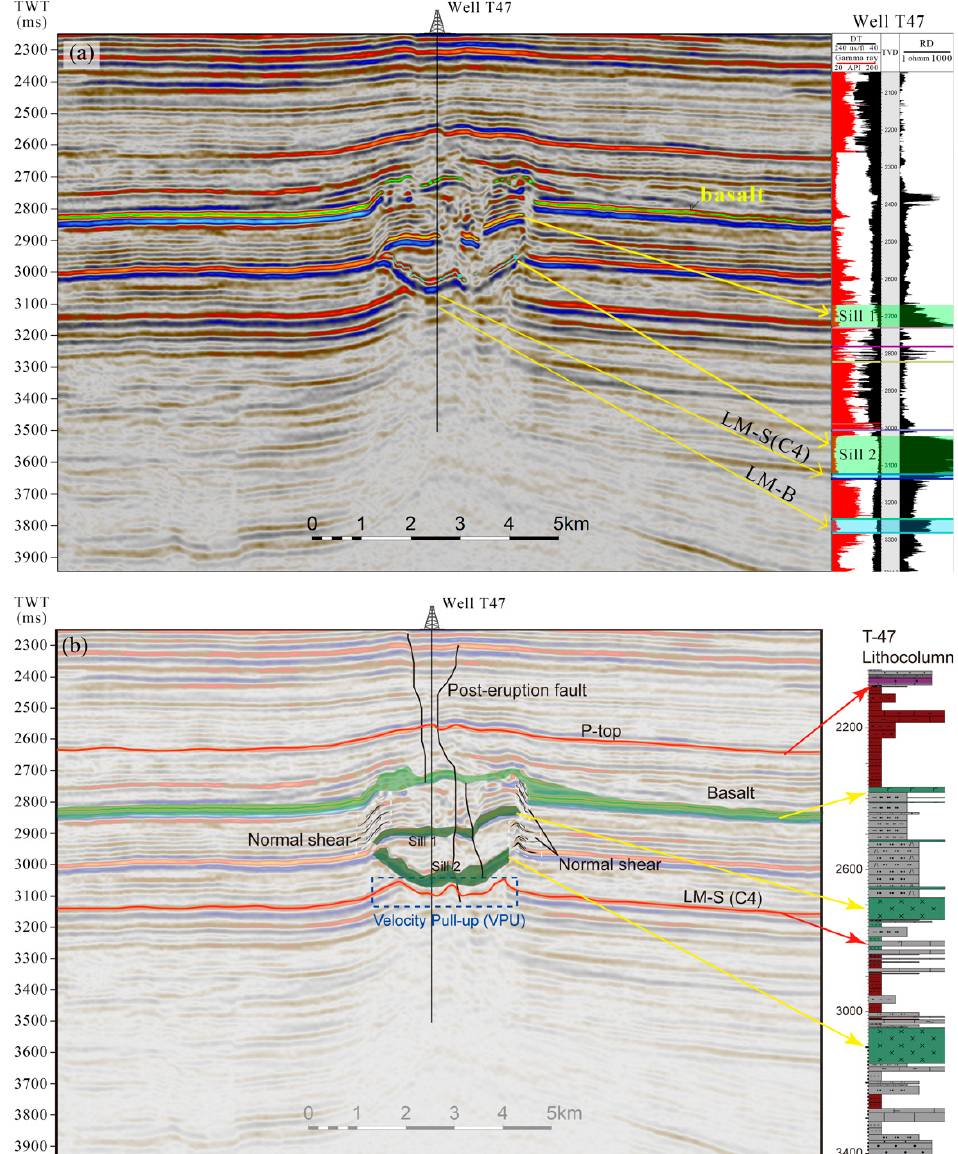
Figure 3. ( a ) Seismic profile across well TZ-47, illustrating the geometry, scale, and seismic expression of two basaltic sills in TZ-47 area, and their correlations with down-well logging data; ( b ) interpretation sketch of the seismic profile and its correlation with the lithocolumn of T-47. Acronyms used in well logging data: DT, compressional wave delay time; TVD, true vertical depth sub-sea; RD, deep resistivity; GR, gamma ray. Reflectors, including standard limestones (LM-S), C4 and bioclastic limestones (LM-B) are defined in Section 4.3.